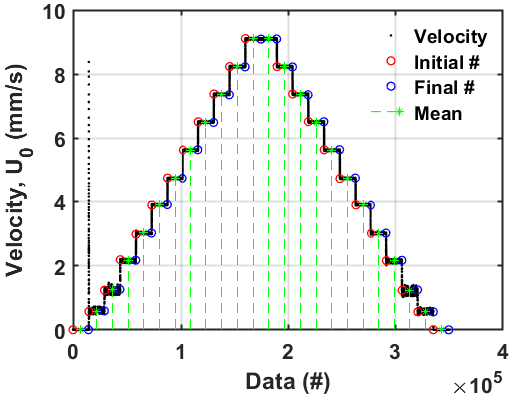
Figure 3. Velocity variation strategy used and evaluation of mean velocities.